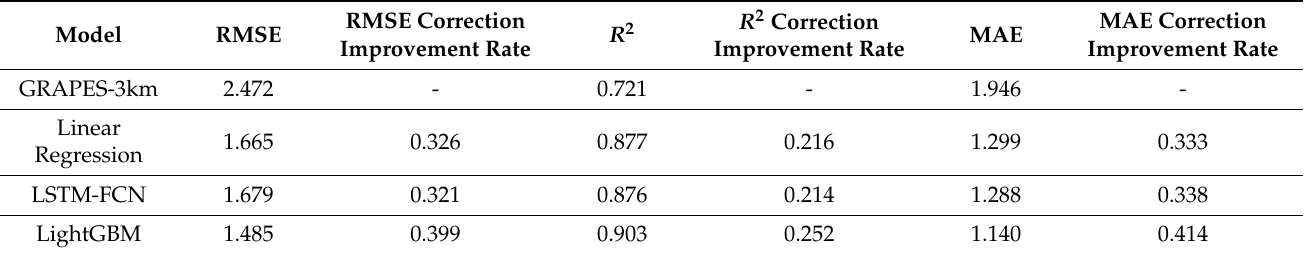
Table 2. Overall average temperature forecast scores and improvement rates from the correction methods in September